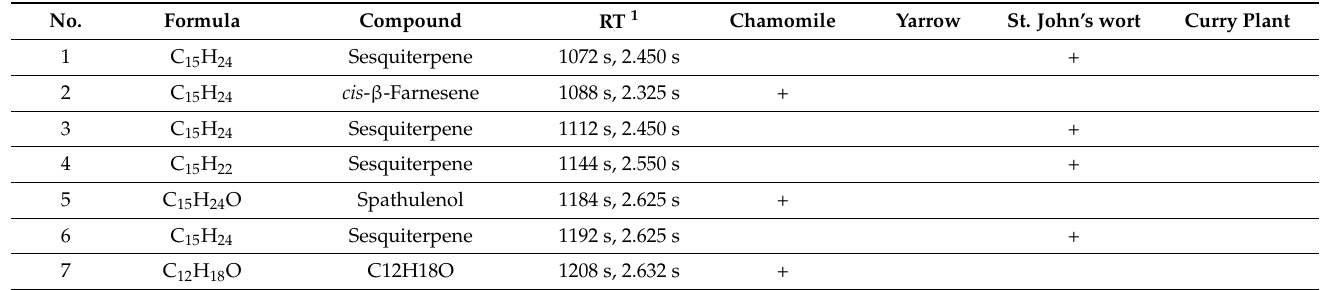
Table 2. List of organic compounds identified in plant extracts with GC×GC-HRMS.